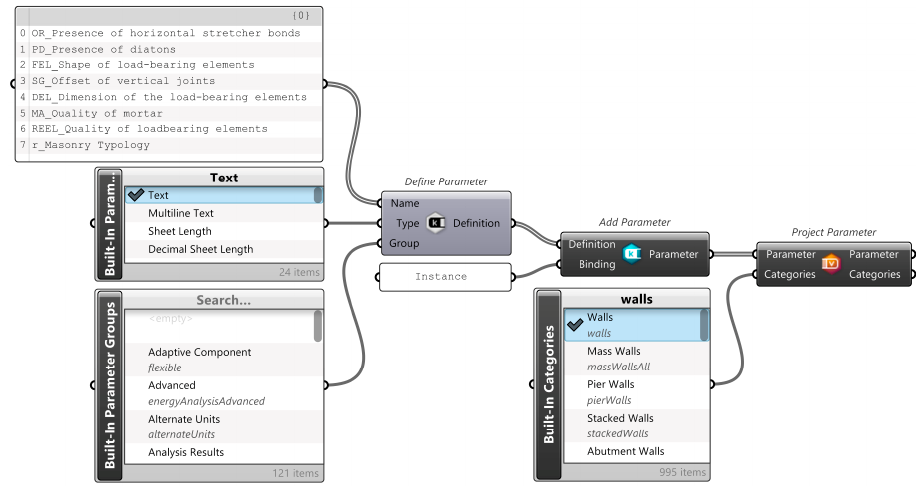
Figure 4. VPL code translating the IQM parameters for the masonry categories to wall instances’ properties in the IQM Revit template.